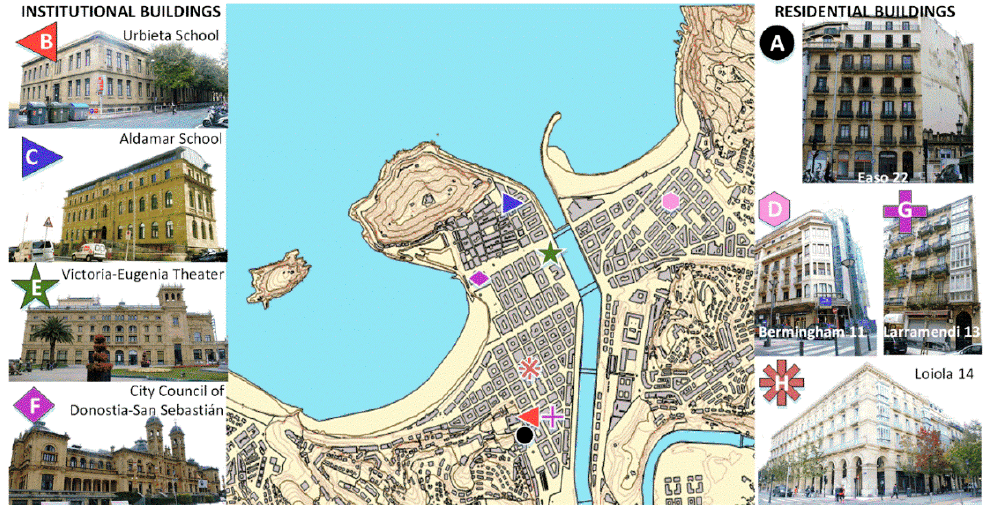
Figure 1. Location and building use of the tested cases in the city of Donostia-San Sebastián.